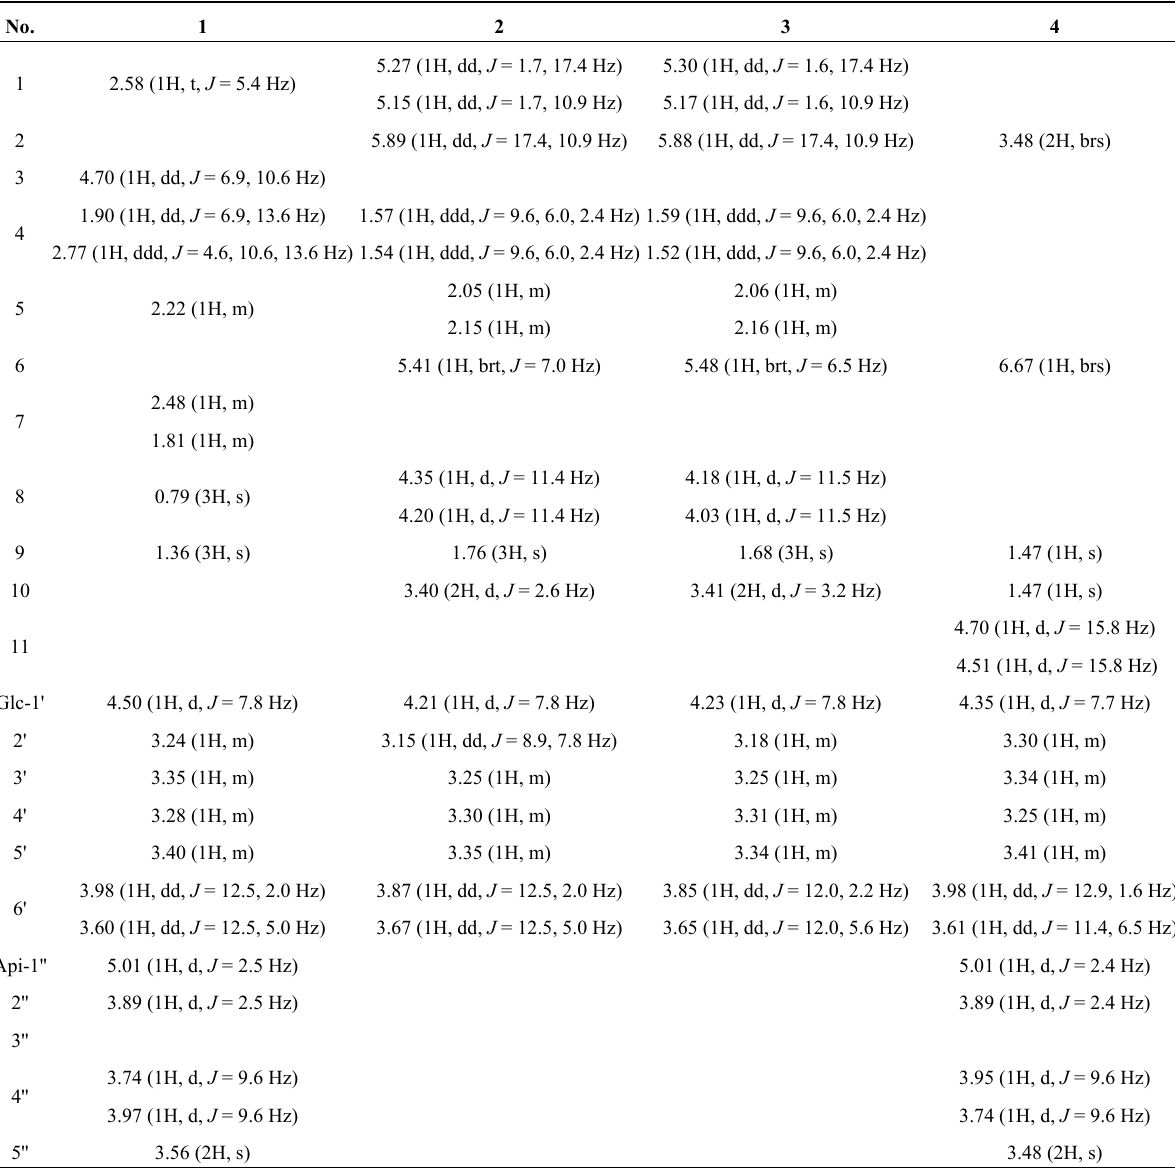
Table 1. 1 H-NMR data for compounds 1 – 4 (400 MHz in CD